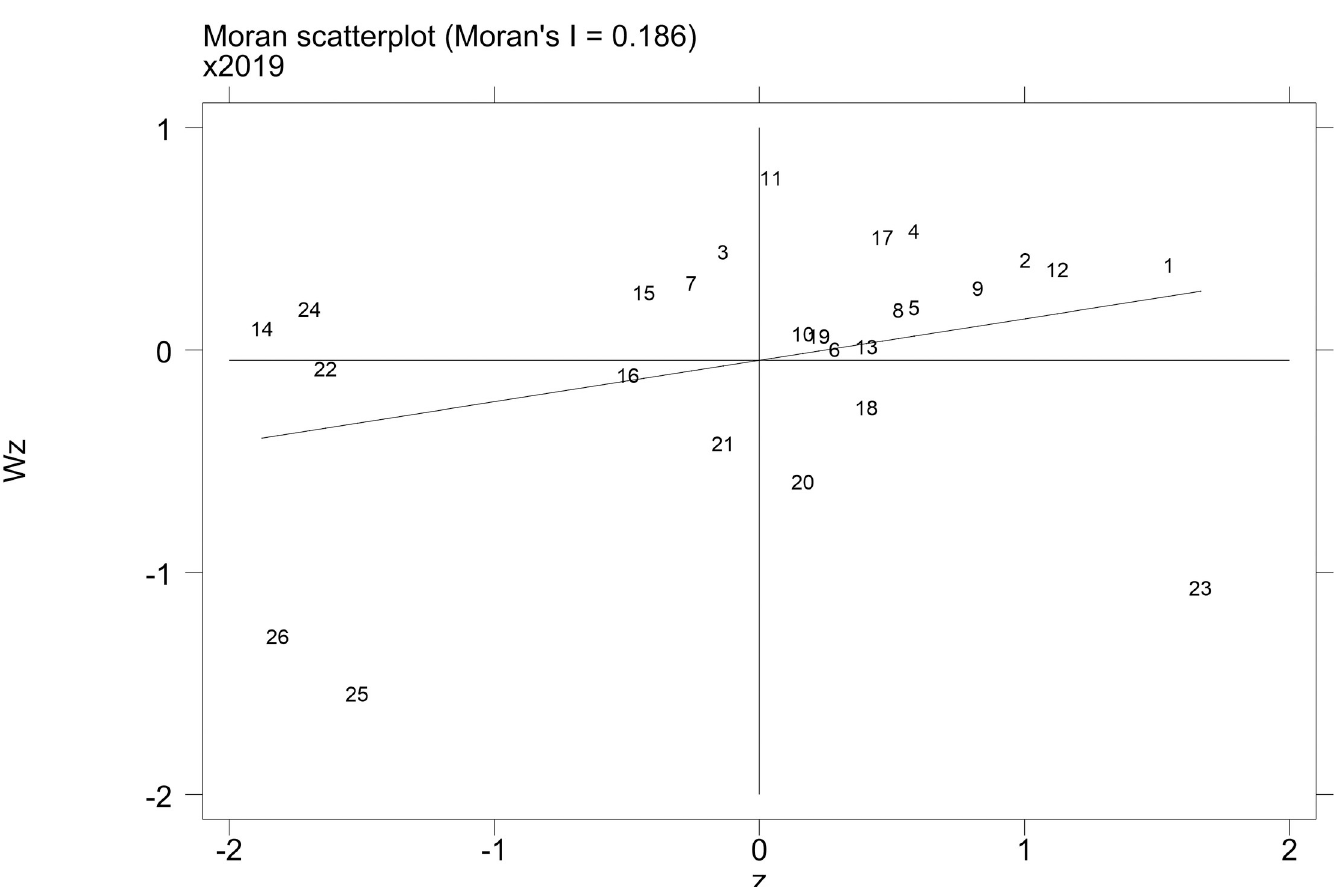
Fig 4. Moran scatterplot diagram of urban innovation and integrated transport efficiency in the Yangtze River Delta in